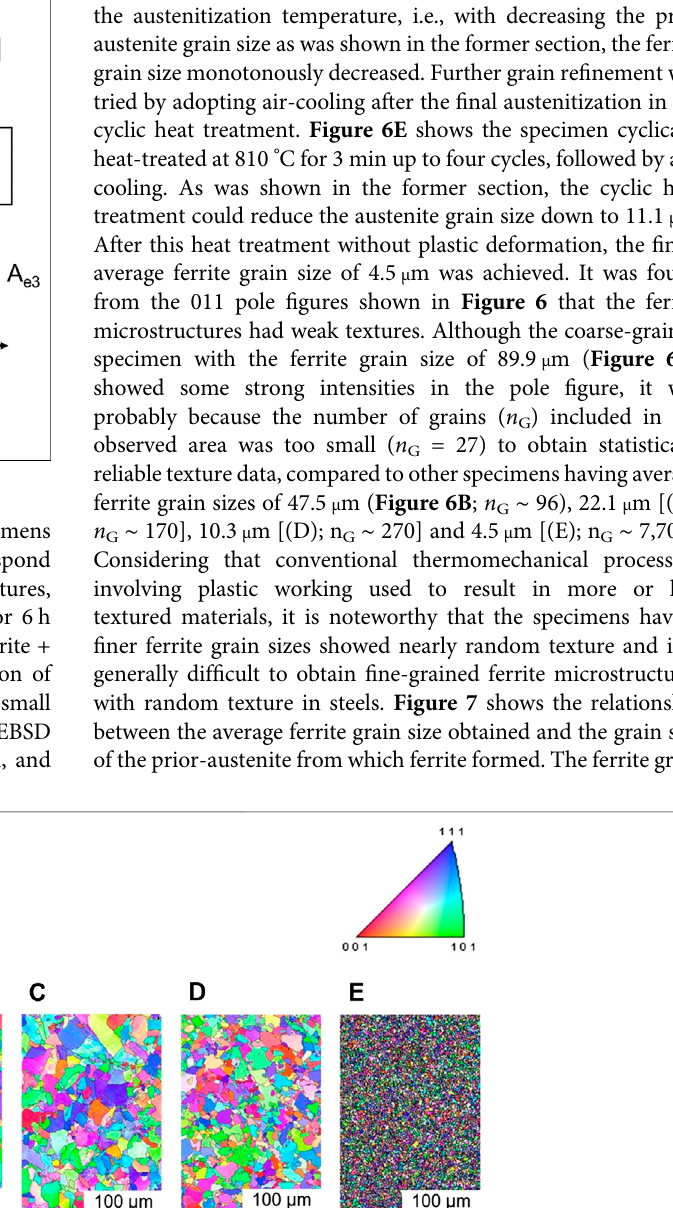
Frontiers in Materials |